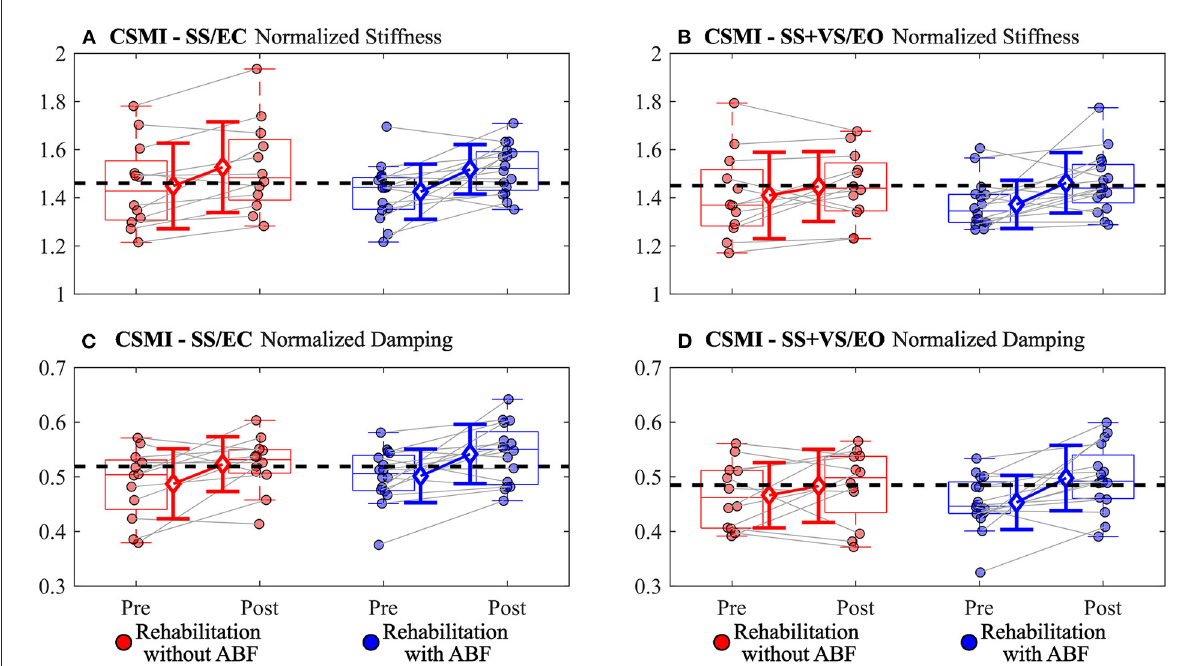
FIGURE3 Individual participant data pre- and post-rehabilitation for groups without audio biofeedback (ABF—red) and with ABF (blue) for (A) normalized stiffness during surface-tilt with eyes closed (SS/EC), (B) normalized stiffness during combined surface-tilt and visual-tilt with eyes open (SS + VS/EO), (C) normalized damping during SS/EC, and (D) normalized damping SS + VS/EO. Central box shows median (center line) with upper and lower quartiles defined by 0.75 quantile and 0.25 quantile values, respectively. Whiskers extend to maximum and minimum values that are not considered outliers. Mean group values are indicated by open diamonds with + /- 1 standard deviations. Gray lines connect individual participant data. Blacked dashed line indicates mean value derived from control subjects in Supplementary material from Peterka et al. (9). Values moving toward the healthy control mean value indicate improved